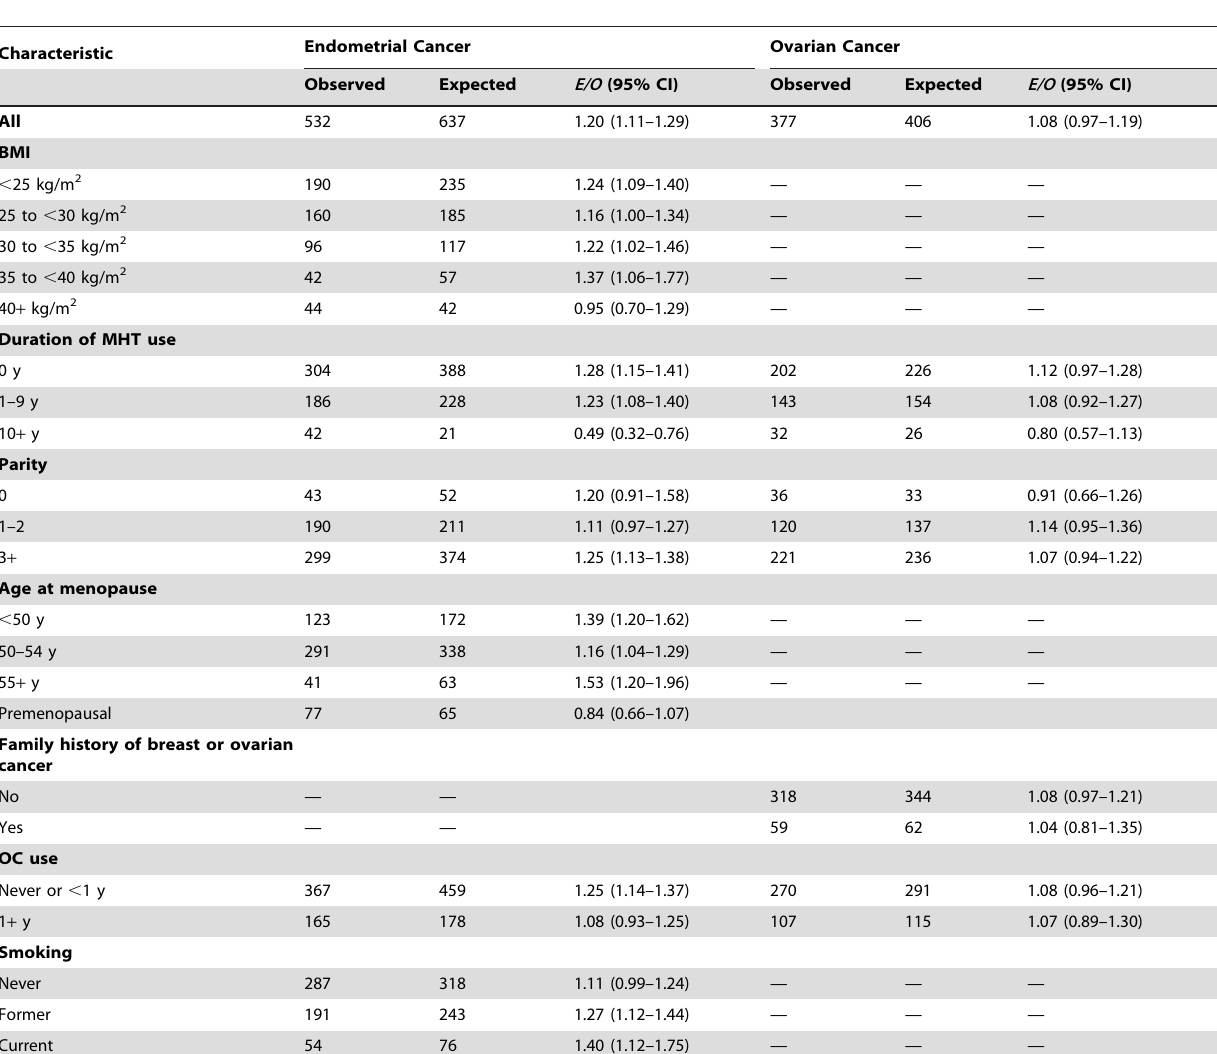
Table 10. Endometrial and ovarian cancer risk prediction during the follow-up of non-Hispanic, white women in the NHS.